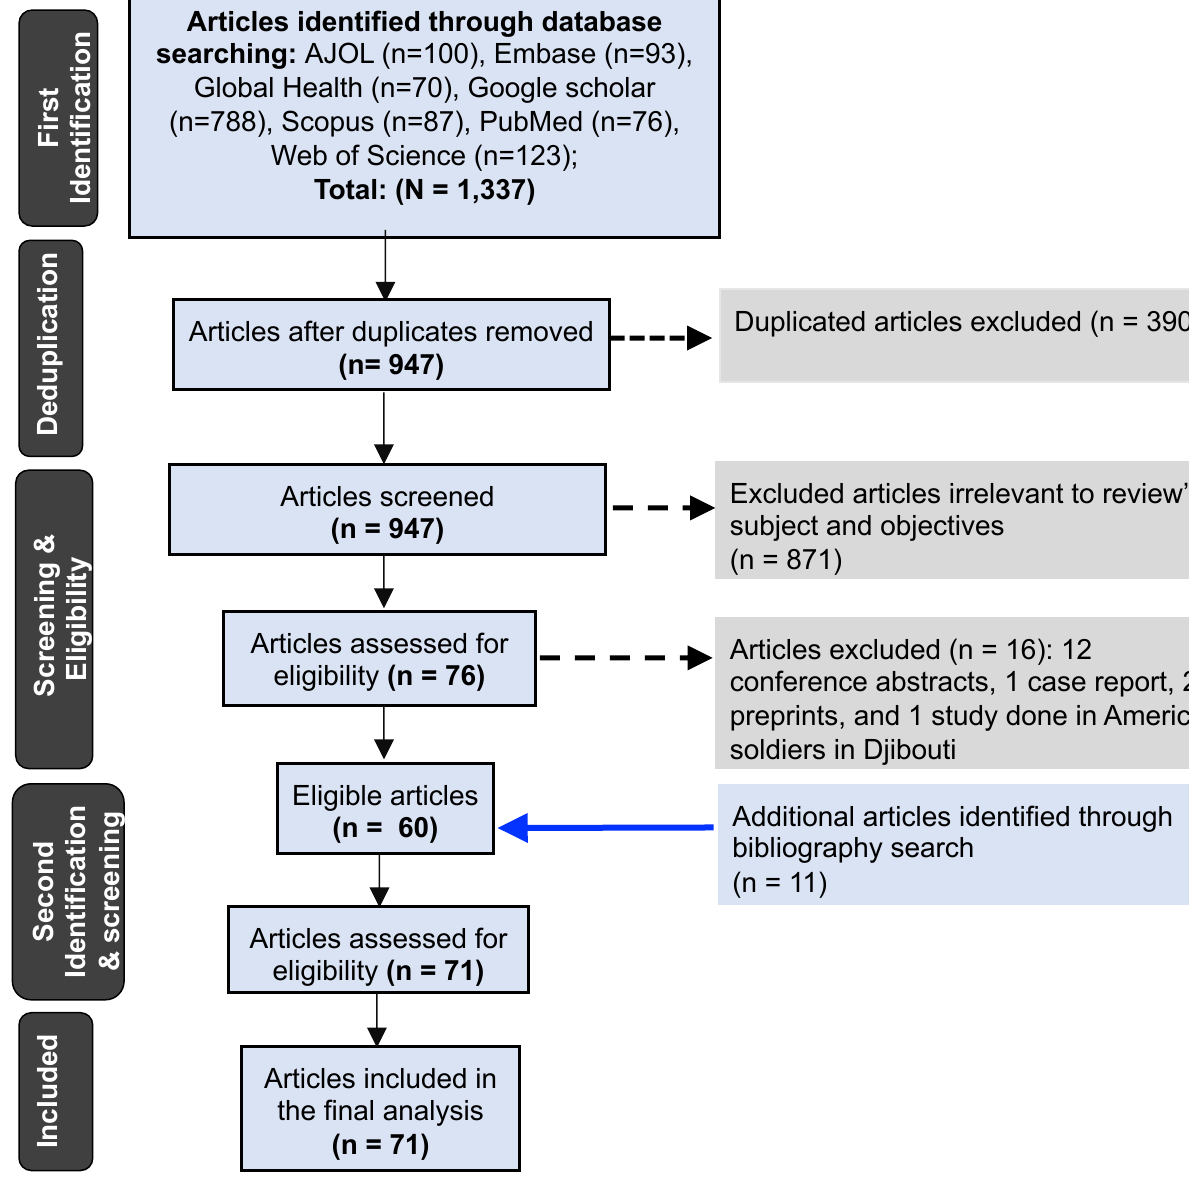
Figure 1. Flowchart showing the exclusion and inclusion criteria of studies analyzed. A total of 87% (62/71) of the studies generated and analyzed new viral sequences, and 13% (9/71) analyzed online sequences. Of the studies that generated new sequences, 53% (33/62) and 37% (23/62) sequenced IAVs locally and abroad, especially in the United Kingdom (U.K.) and the United States (U.S.), respectively. Two studies sequenced IAVs both locally and abroad, and four studies did not report where sequencing was performed. A total of 56% (35/62) of the studies used Sanger sequencing technology and were published between 1996 and 2020. Only 8% (5/62) of the studies used next-generation sequencing (NGS) and were published between 2011 and 2021 [75,76,81,97,98]. Two studies used both Sanger and NGS [26,73]. Another study did not clearly report whether Sanger or NGS was used [94]. Three studies used pyrosequencing or Sanger and pyrosequencing or Sanger and targeted HA analysis. Sixteen studies did not describe the technology